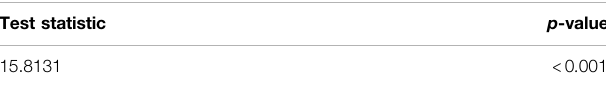
TABLE 5 | Test summary on the phone-call